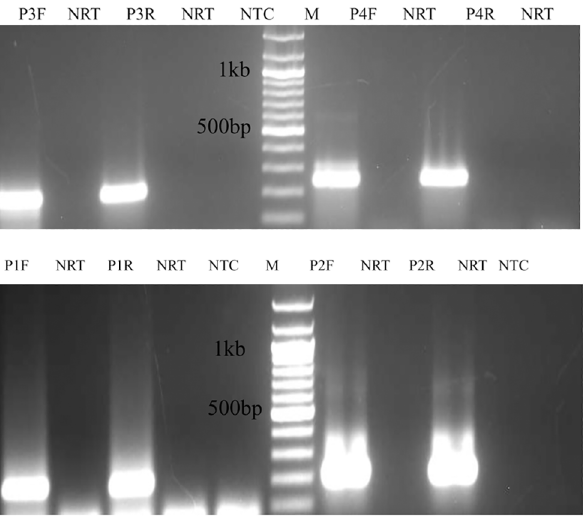
Fig 2. Determination of pRNA orientation in HPV18 integrated HeLa cells. RNA extracted from the cells was DNase treated and subjected to reverse transcription with pRNA specific forward (antisense specific) or reverse (sense specific) primers and PCR performed with forward and reverse primers together. P1F: RT performed with P1F primer and PCR with P1F and P1R primers, P1R: RT performed with P1R primer and PCR with P1F and P1R primers, P2F: RT performed with P2F primer and PCR with P2F and P2R primers, P2R: RT performed with P2R primer and PCR with P2F and P2R primers, P3F: RT performed with P3F primer and PCR with P3F and P3R primers, P3R: RT performed with P3R primer and PCR with P3F and P3R primers, P4F: RT performed with P4F primer and PCR with P4F and P4R primers, P4R: RT performed with P4R primer and PCR with P4F and P4R primers, NRT:negative RT, NTC: no template Control, M: 100bp